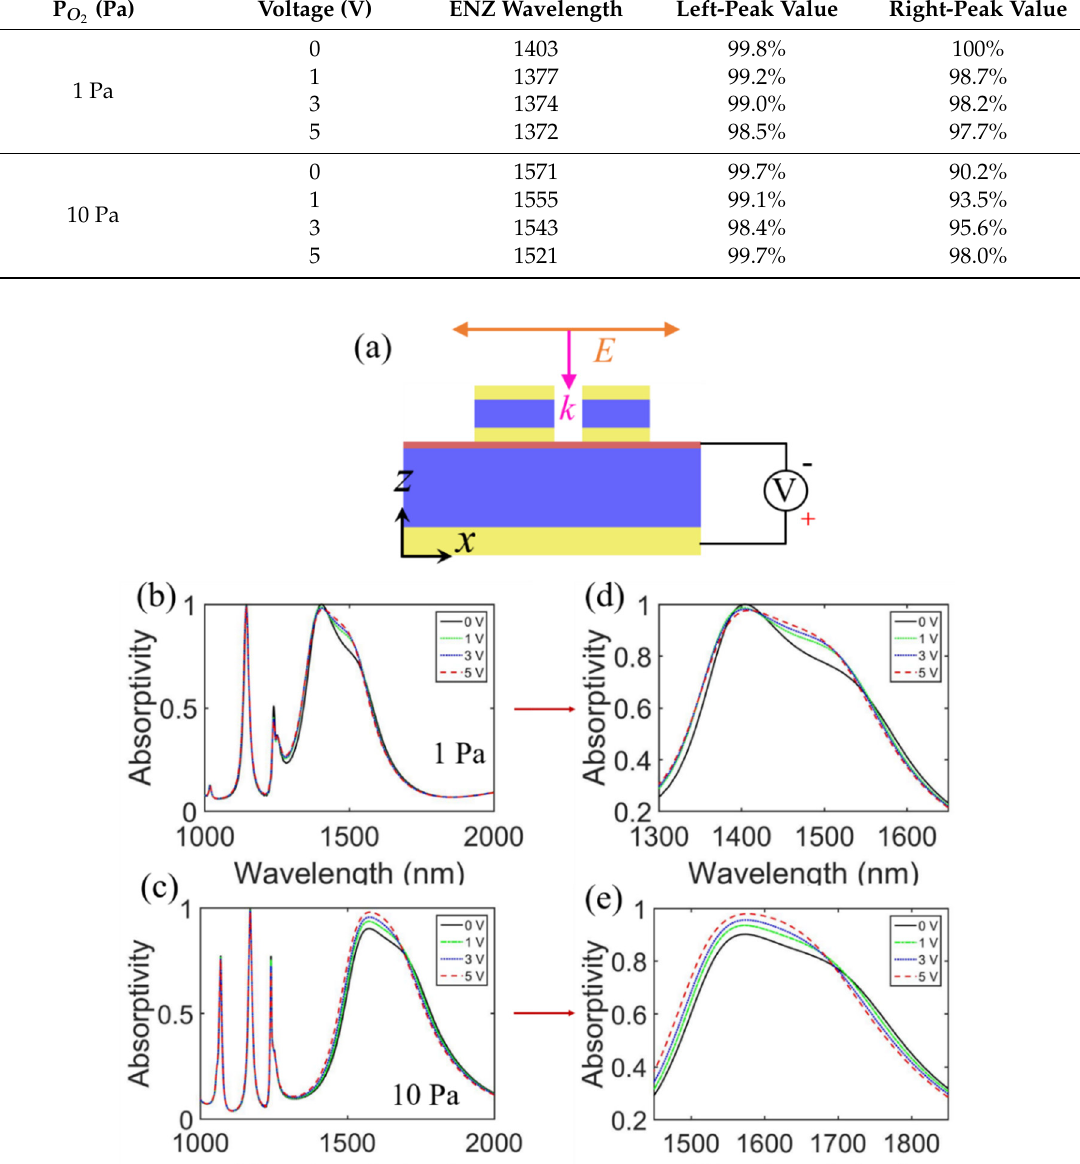
Table 1. The calculated epsilon ‐ near ‐ zero (ENZ) wavelength of the ITO ultra ‐ thin film based on the Drude model under different voltages for ITO fabricated at 1 and 10 Pa. The left ‐ peak value and the right ‐ peak value represent the maximum of the absorptivity at the short wavelength and long wavelength, respectively (see Figure 6b,c).